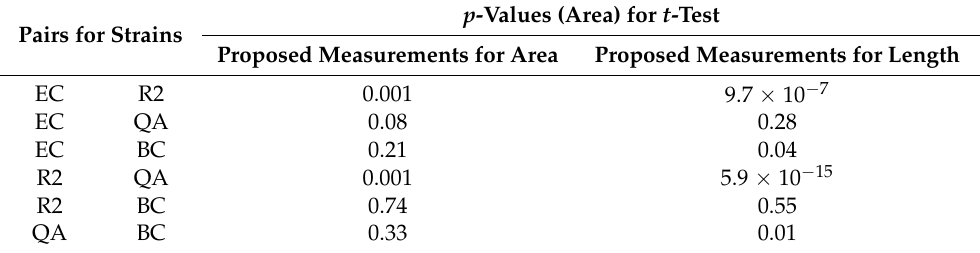
Figure 5. Automatically measured cell area vs. cell length.